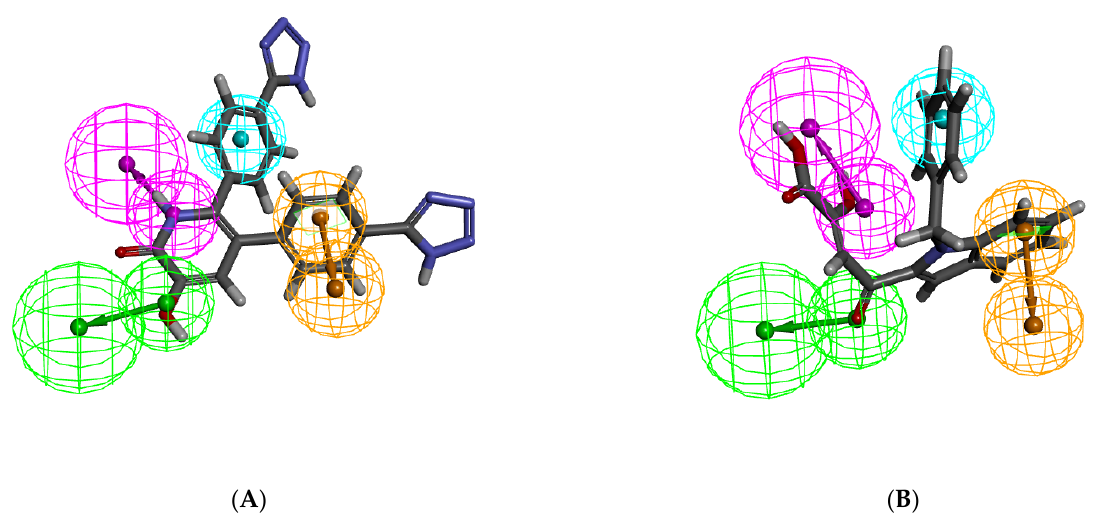
Figure 4. Correlation graph between experimental and estimated activity values in logarithmic scale for training and test set compounds based on Hypo1.